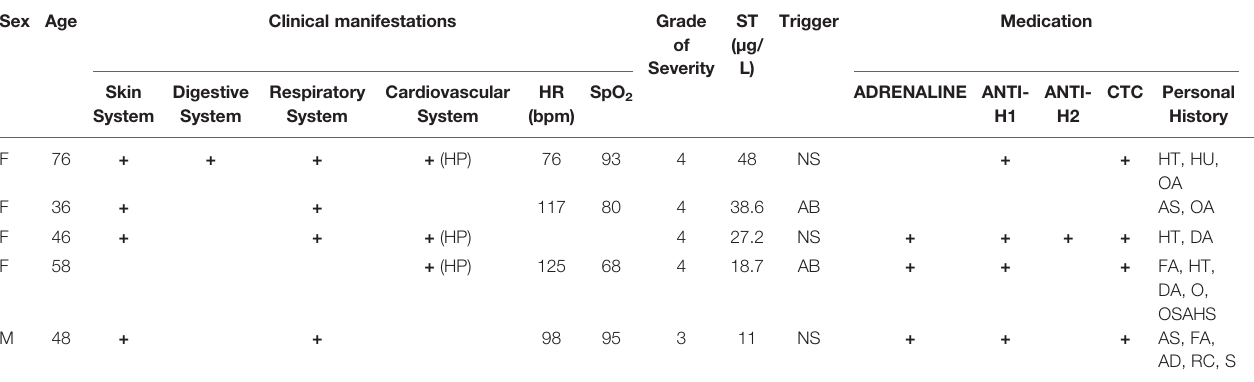
TABLE 1 | Clinical features of the anaphylactic reaction